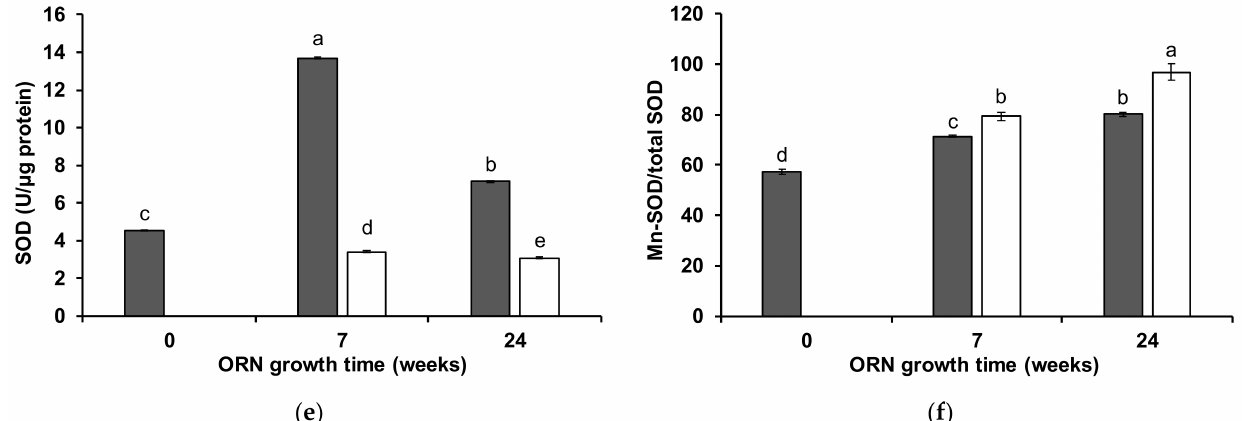
Figure 4. Activity (average and standard error) of the antioxidant enzymes ascorbate peroxidase ( a ), catalase ( b ), glutathione reductase ( c ), guaiacol peroxidase ( d ), superoxide dismutase ( e ) and ratio of manganese superoxide dismutase isoform activity over activity of all isoforms ( f ) in shoots of wheat grown in disturbed (grey columns) or undisturbed (white columns) soil with previously grown Ornithopus compressus (ORN), after 0, 7 or 24 weeks. Different letters indicate statistically significant differences ( p < 0.05) based on Tukey’s